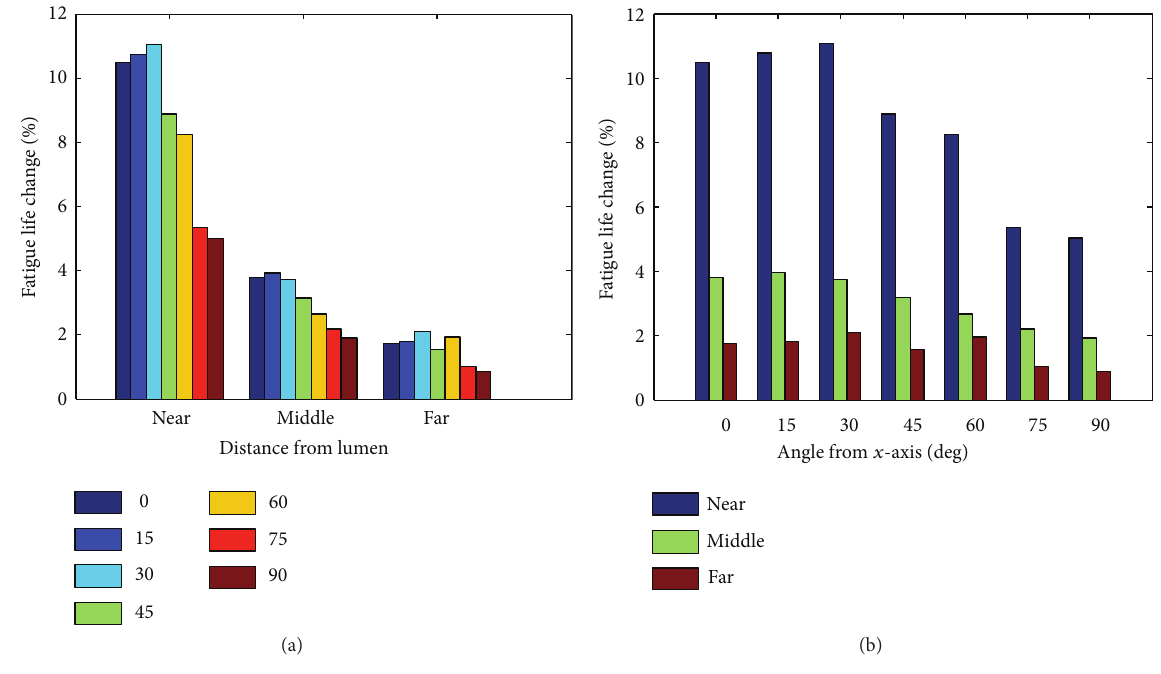
Figure 5: Calcification locations and fatigue life